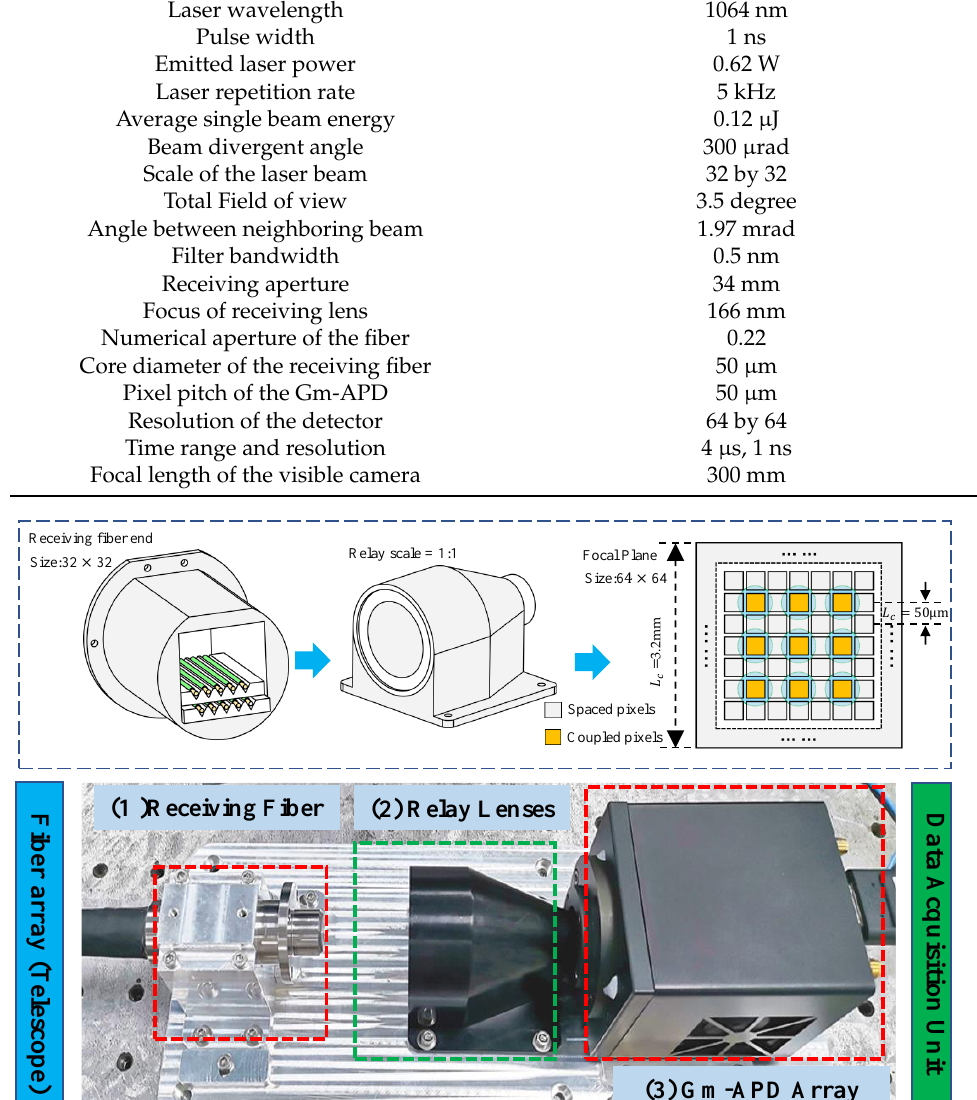
Figure 2. Experimental setup of coupling receiver. The proposed system uses a detector for receiving echo photons that has a scale (64 × 64 pixels) larger than the beam size (32 × 32 beams). This increases the space available for the photosensitive pixel surface and avoids the beam interference caused by crosstalk between detector